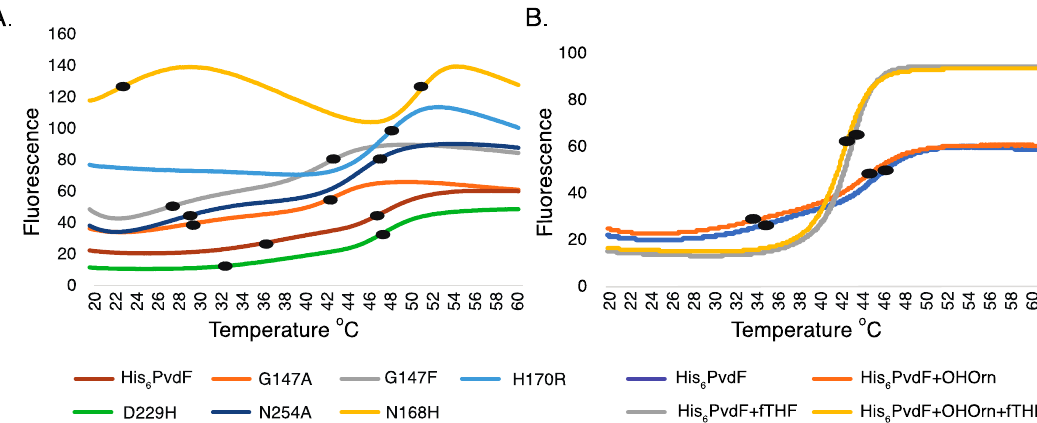
Figure 4. PvdF consists of two independently melting domains. ( A ) Thermal stability tests of PvdF and variants were carried out using differential scanning fluorometry. Black dots indicate inflection points that are likely to represent domain melting events. All the variants had evidence for two inflection points except H170R which showed only one. ( B ) Stability tests of His 6 PvdF in presence of fTHF (formyltetrahydrofolate) (grey and yellow curves) showed a single, cooperative melting event of large amplitude, in contrast to the two inflection points and low amplitudes observed in absence of this substrate (blue and orange curves). In contrast, the presence of OHOrn (hydroxyornithine) (grey and orange curves) did not affect melting of PvdFHis 6 . Spectra are averages of at least three independent enzyme preparations.